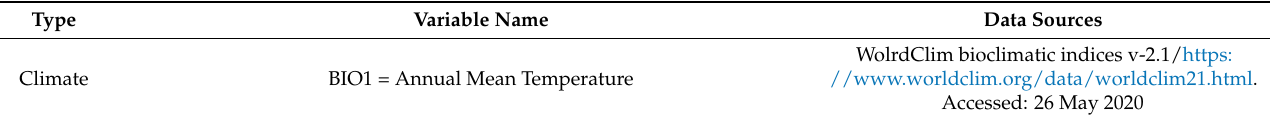
Table A2. Full list of variables and data